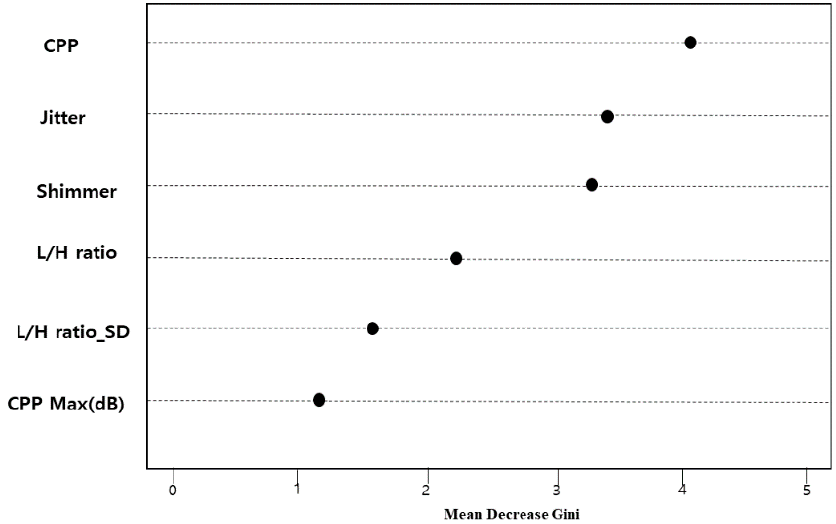
Figure 5. Importance of variables for identifying hypokinetic dysarthria (presenting only the top six variables).